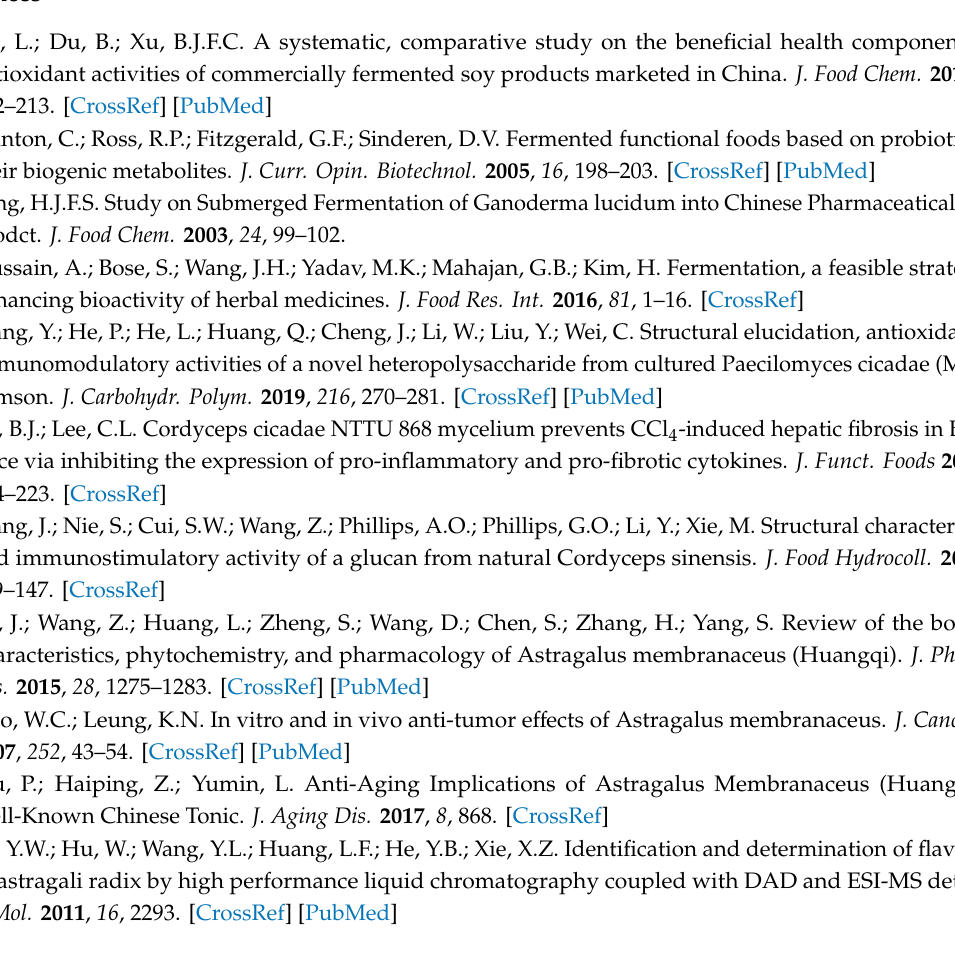
Supplementary Materials: Figure S1: Proposed fragmentation pathways for representative flavonoids detected in negative ion mode; Figure S2: Proposed fragmentation pathways for representative saponin detected in negative ion